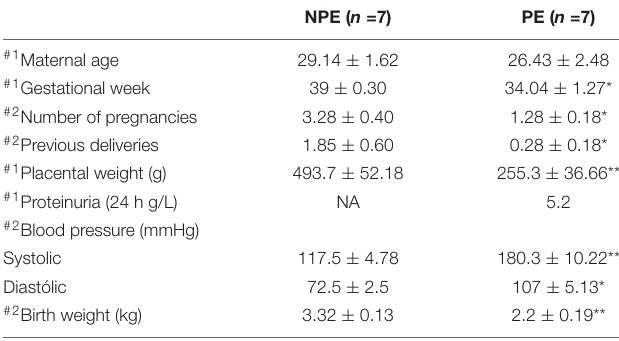
TABLE 1 | Clinical characteristics of controls and patients with pre-eclampsia